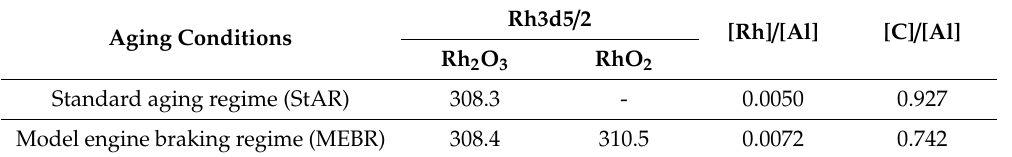
Figure 5. XPS spectra (Rh3d region) for the Rh / (Al 2 O 3 -CeZrO 2 ) catalyst aged at standard conditions ( 1 ) and in the model engine braking regime ( 2 ). Table 2. XPS data for the aged samples of Rh / (Al 2 O 3 -CeZrO 2 ) catalyst.